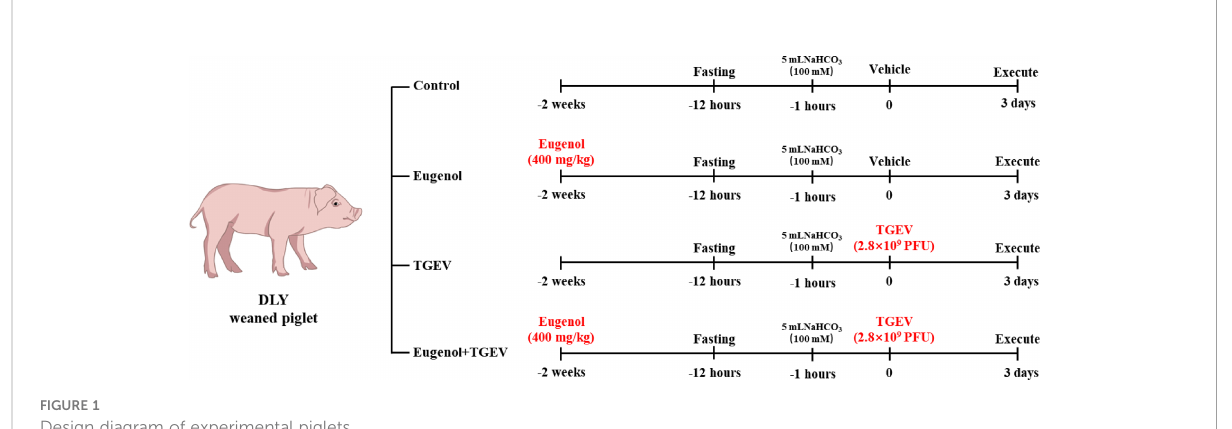
FIGURE 1 Design diagram of experimental piglets.